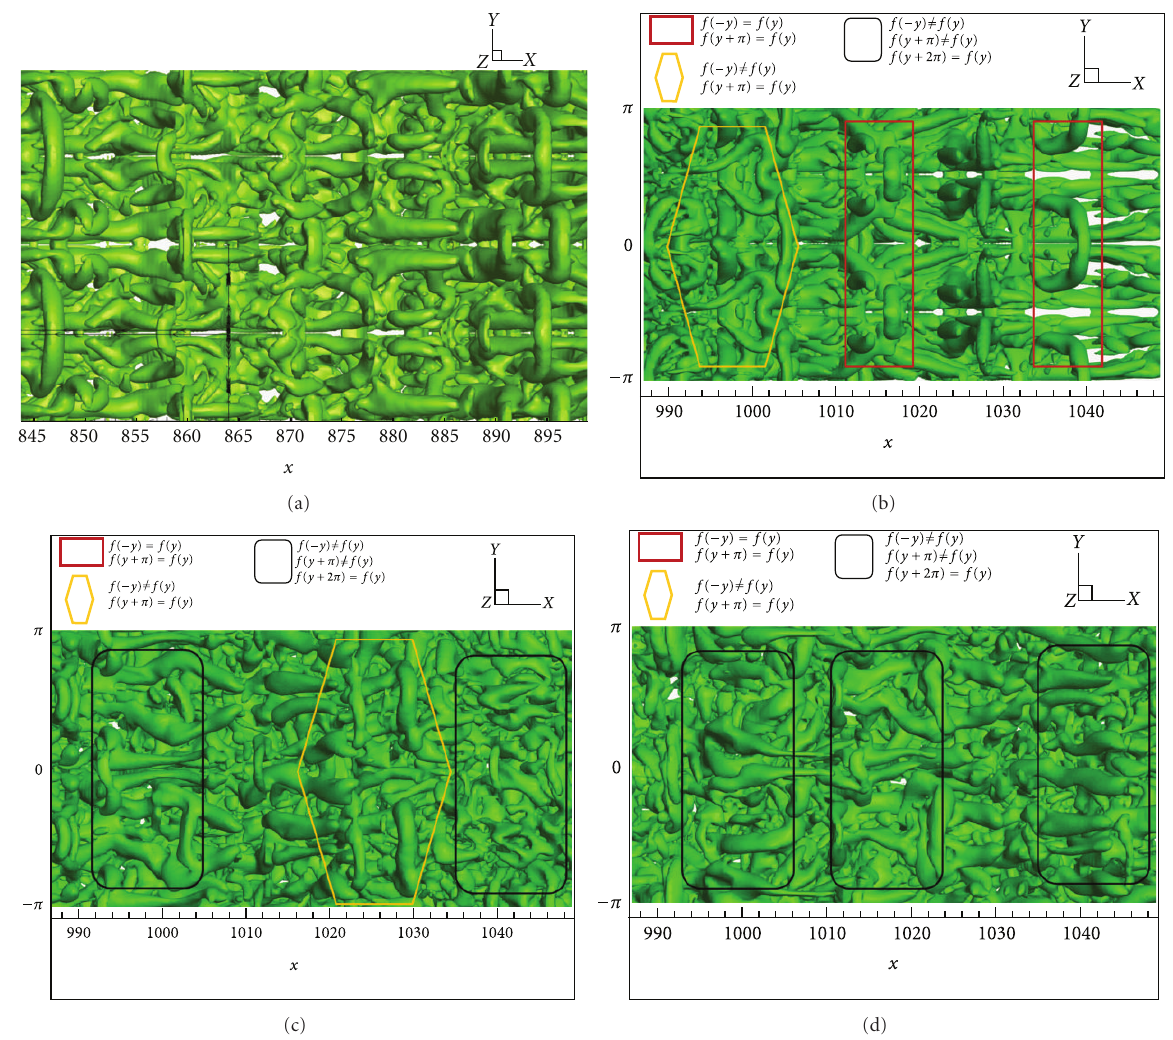
Figure 38: (a) Whole domain is symmetric and periodic — a × cos2 y (the period = π ; spanwise domain is − π < y < π ), (b) symmetric and asymmetric—redrectangular: periodic and symmetric at y = − π/ 2, 0, π/ 2, that is, f ( − π/ 2 − y ) = f ( − π/ 2+ y ), f ( − y ) = f ( y ), f ( π/ 2 − y ) = f ( π/ 2 + y ); yellow diamond: periodic, f ( y + π ) = f ( y ), period = π ; but asymmetric f ( − y ) / = f ( y ); the spanwise domain is − π < y < π , (c) periodic but asymmetric—yellow diamond: periodic, period = π ; black box: periodic but period = 2 π ; the spanwise domain is − π < y < π . (d) Periodic but asymmetric—all black boxes: periodic but asymmetric (period = 2 π ); the spanwise domain is − π < y < π